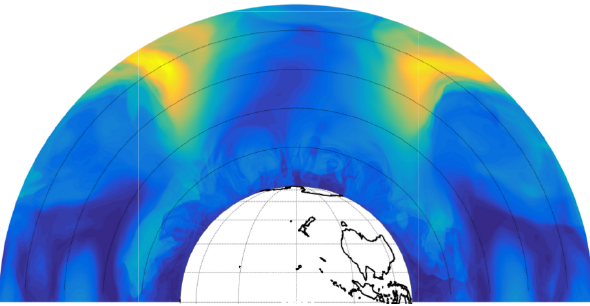
Figure 6. 15 August 1979 00:00:00UTC. M for τ = 5 days dis- played along the vertical slice passing through longitudes 90 ◦ W and 90 ◦ E. The black lines on the stratosphere correspond to heights 10, 20, 30 and 40km and black lines on the Earth’s surface corre- spond to latitudes 15, 30, 45, 60, and 75 ◦ S.